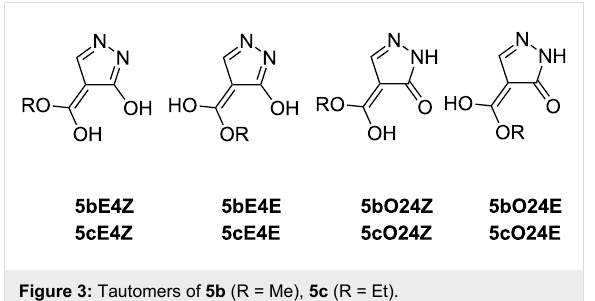
Figure 3: Tautomers of 5b (R = Me), 5c (R = Et).